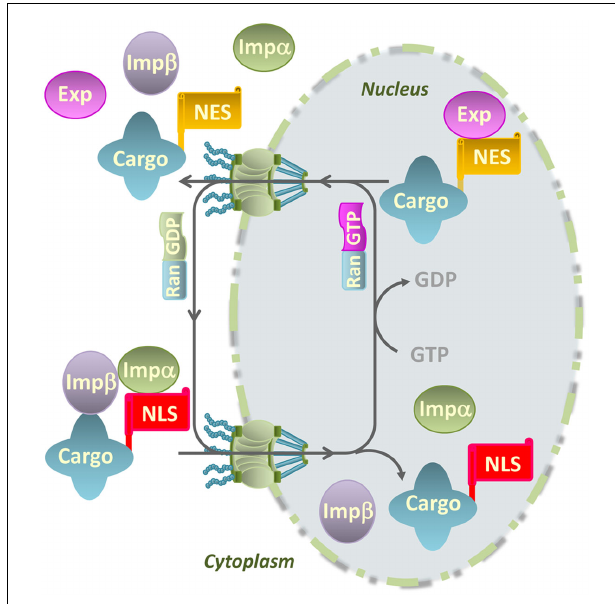
FIGURE 1 | Model for nucleocytoplasmic transport of macromolecules through the nuclear pore complex. Cytoplasmic proteins with a nuclear localization signal (NLS) are translocated into the nucleus through nuclear pore complexes that are composed of nucleoporins and span the double membrane of the nuclear envelope.The NLS in cargo proteins is recognized by importin- α (Imp α ) that bridges the interaction of cargo proteins with importin- β (Imp β ) and promote their transport into the nucleus.The directionality of transport is maintained by the Ras-related nuclear (Ran) protein through its binding to GDP (cytoplasmic side) or GTP (nuclear side). Export receptors or exportins (Exp) recognize nuclear export signals (NES) in cargo proteins, promoting their nuclear export to the